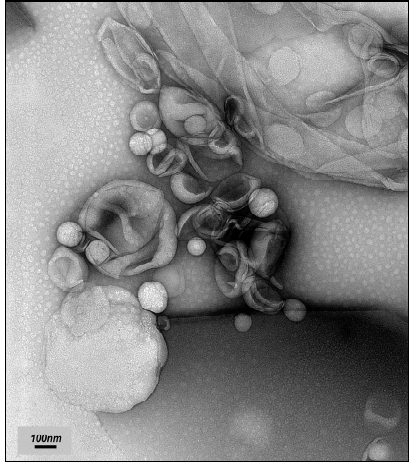
Figure 2. Transmission electron micrographs of liposomes containing cytarabine and methotrexate (L DPPC/AraC/MTX ) obtained by the modified reverse-phase evaporation method (mREV), negatively stained (2% uranyl acetate solution) on a carbon-coated copper grid, magnification: 50,000 times; at room temperature.